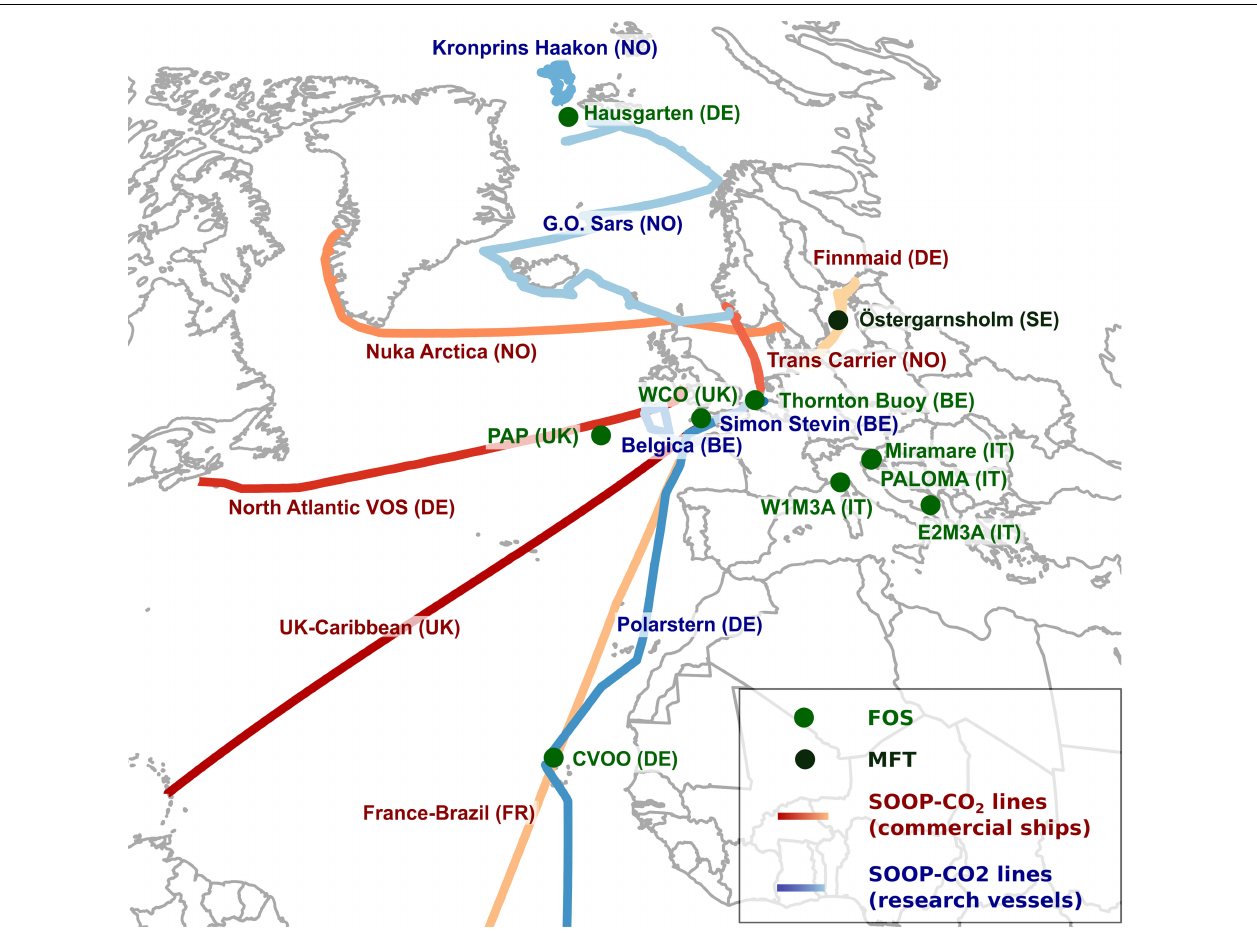
FIGURE 2 | Distribution of stations and coverage of ICOS-Oceans network as in February 2019. Please note that ICOS-Oceans is a developing network. Please find a complete and up to date station list and information about the stations in https://otc.icos-cp.eu/station-network.